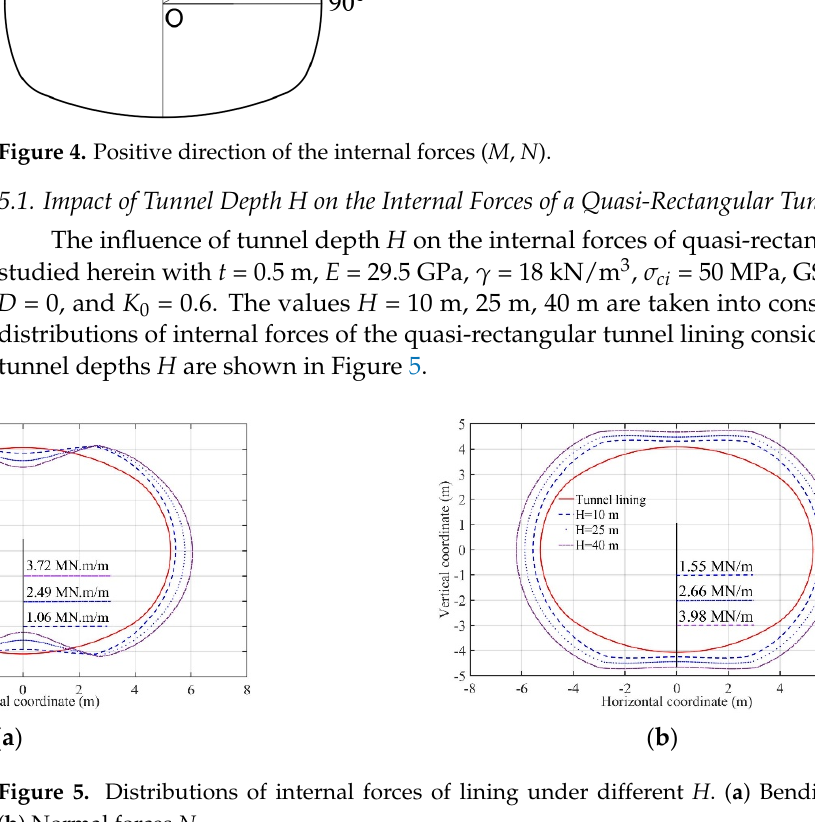
Figure 4. Positive direction of the internal forces ( M , N ).